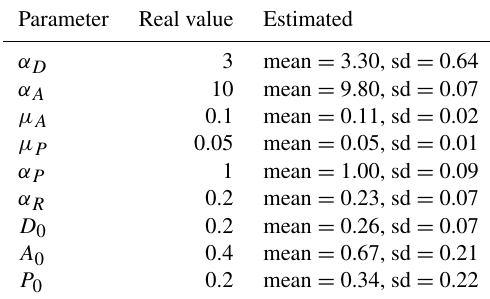
Table 2. Parameter values. Real values used to generate our data points and the mean and standard deviation of the posterior